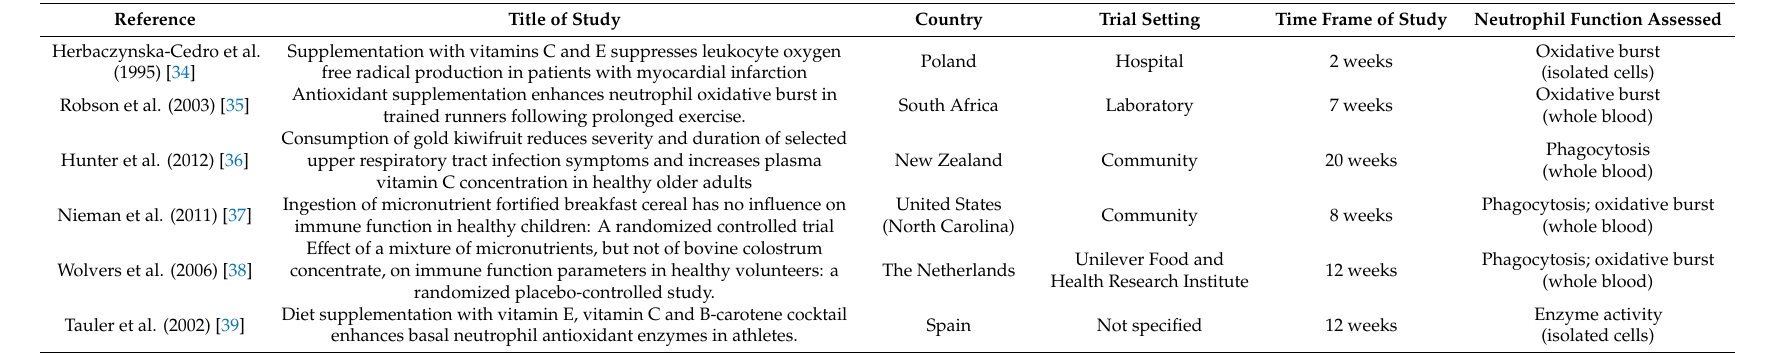
Table 2b. Characteristics of combination supplementation